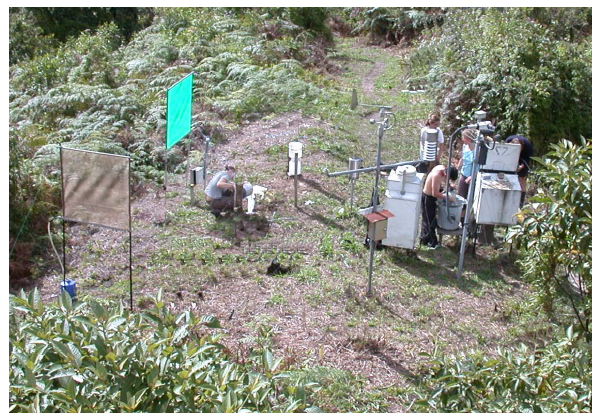
Fig. 2. ECSF climate station with rain and fogwater samplers.